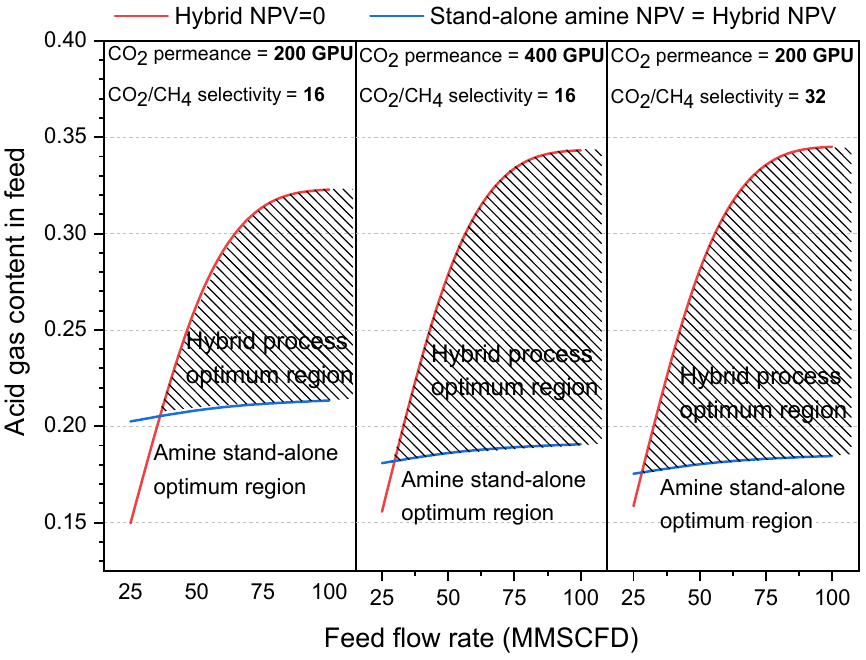
Figure 9. The hybrid process and the amine stand-alone process preferred ranges at various feed conditions (feed flowrate and acid gas content). Above the red lines, the hybrid process is not feasible (NPV <0), while below the blue lines, the amine stand-alone process is more economical (stand-alone amine NPV > hybrid process NPV).